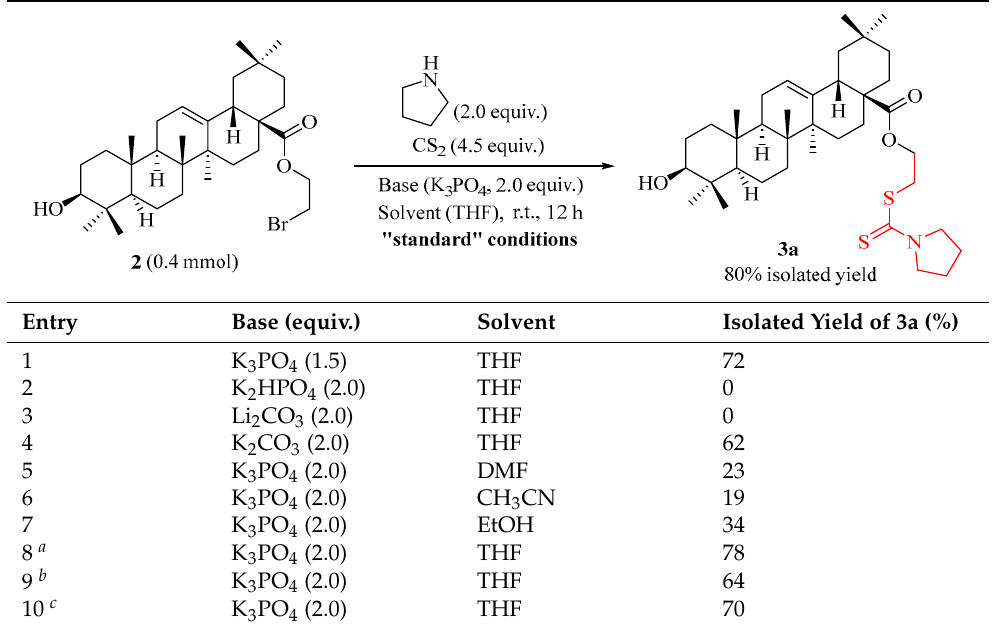
Table 1. Optimization of Reaction Conditions.